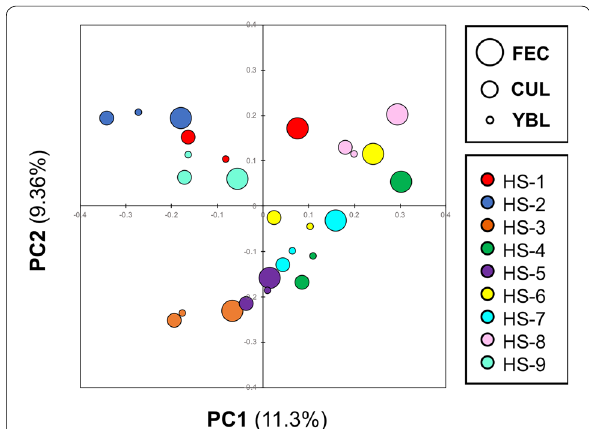
Fig. 2 PCoA of 16S rRNA gene sequences from fecal samples of nine healthy subjects (HS-1–HS-9). The large, medium, and small circles in the PCoA plot represent the microbiota in feces, the corresponding KUHIMM cultures without YBL, and the KUHIMM cultures with 1.5% YBL, respectively. The cultures were sampled at 48 h after